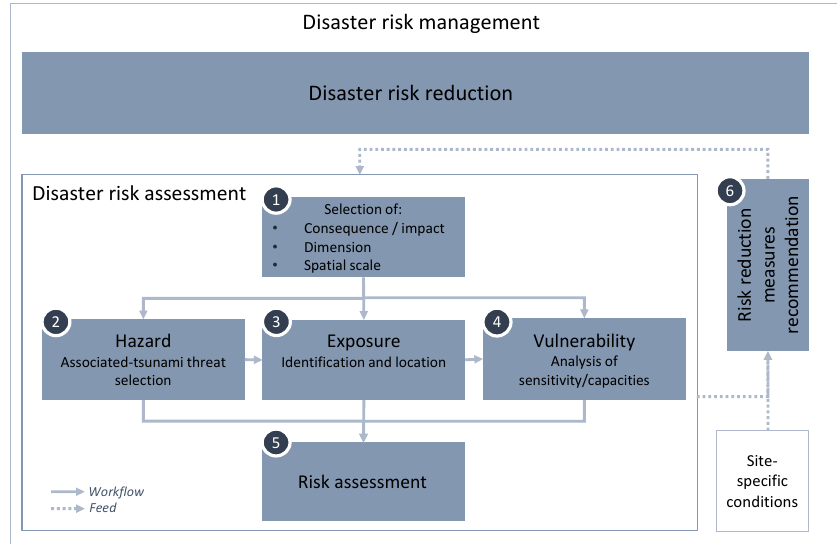
Figure 1. Schematic workflow.